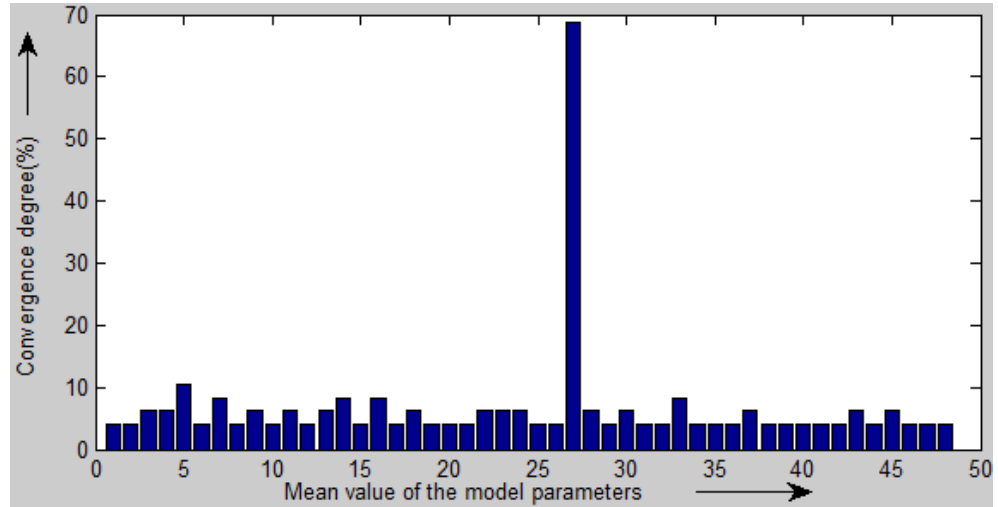
Figure 2. Histogram of hypothesis model